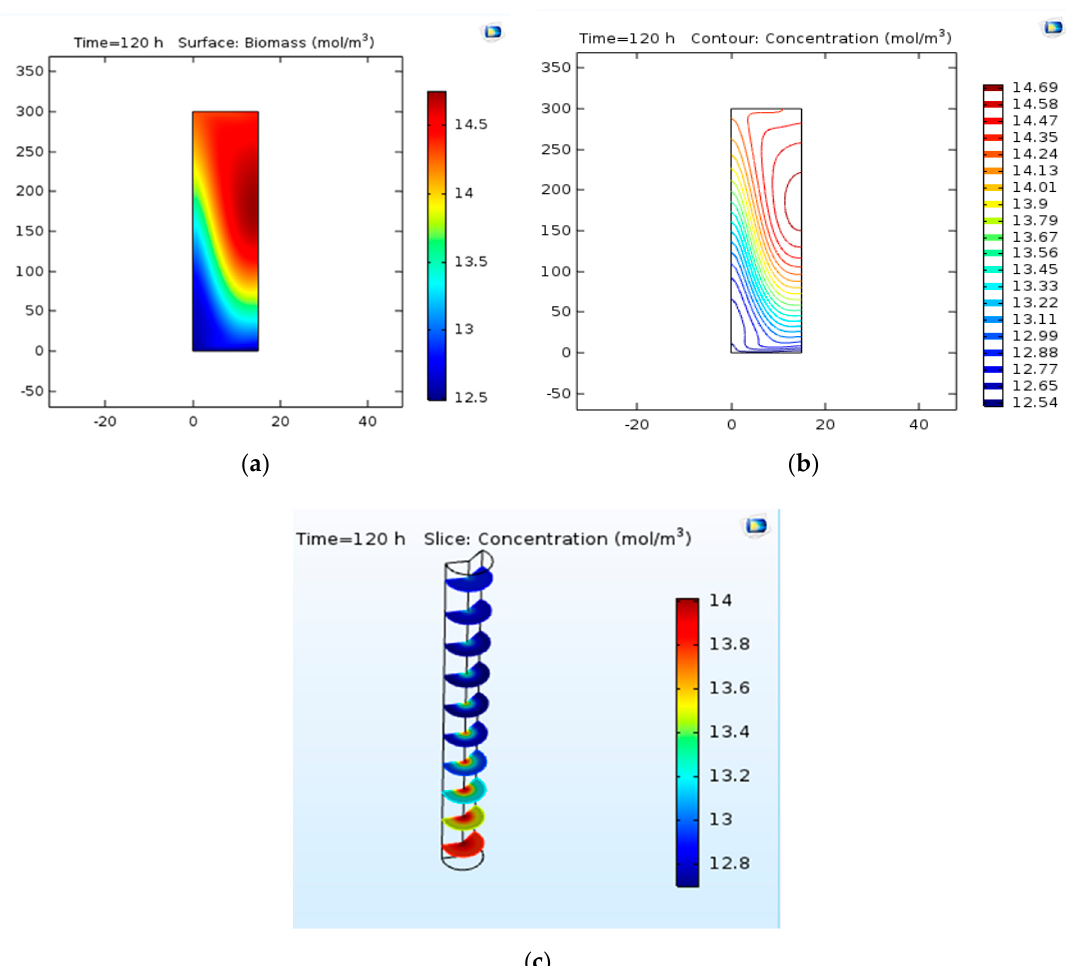
Figure 3. ( a ) The concentration surface contour of biomass. ( b ) The concentration contour of biomass. ( c ) The slice concentration contour of biomass.